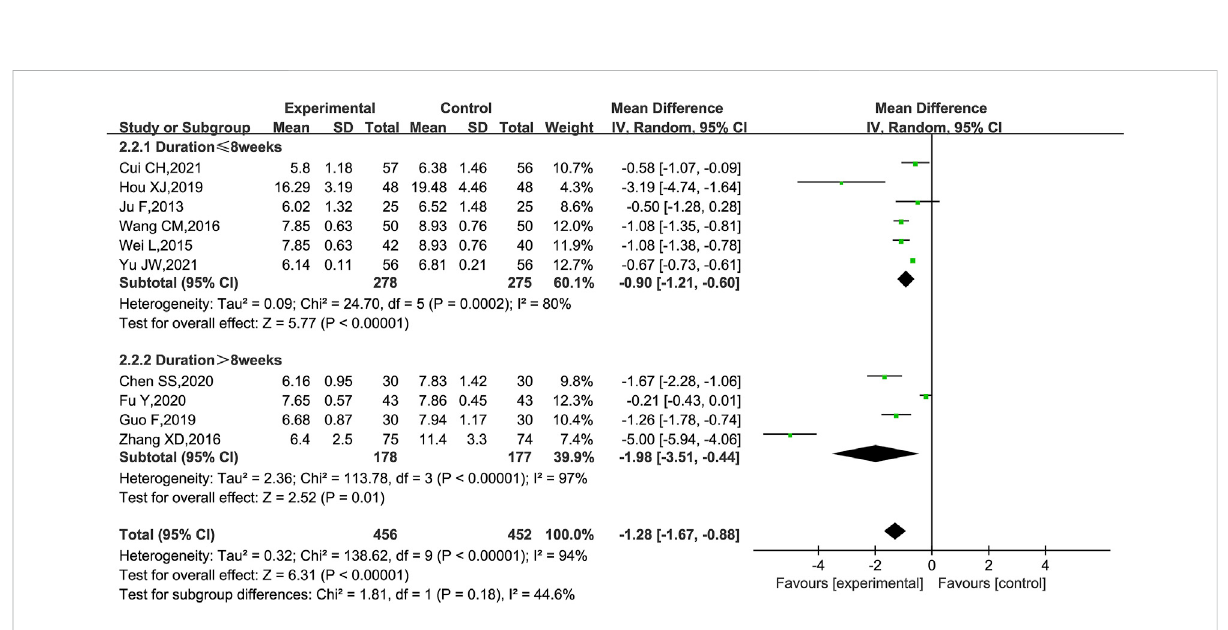
FIGURE 8 Forest plot of BUN for KLXC + Western medicine vs. Western medicine alone (mmol/L).